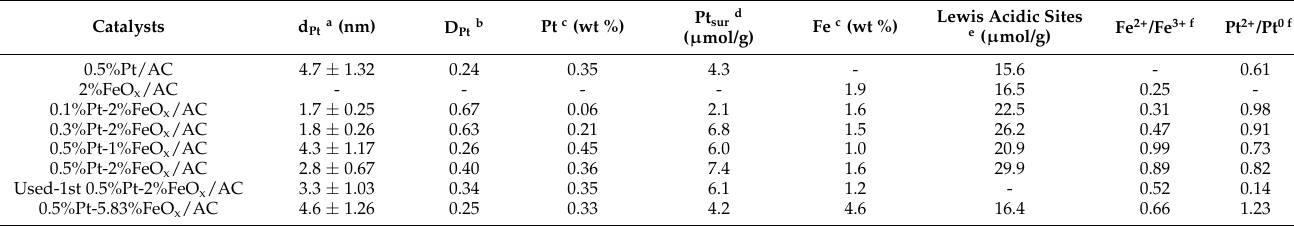
Figure 1. XRD patterns of different catalysts. Table 1. Physicochemical properties of different Pt-FeO x /AC catalysts.